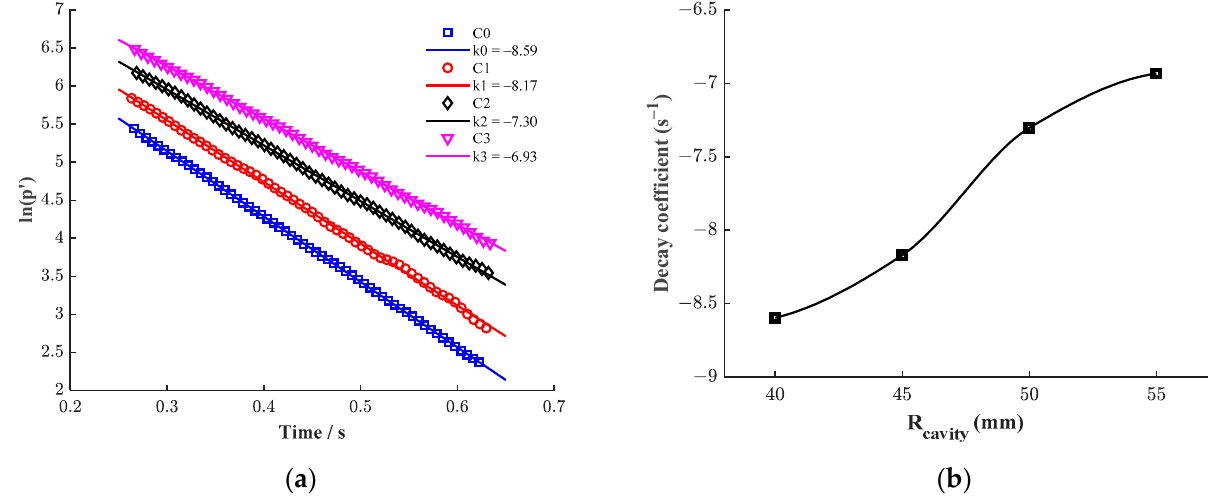
Figure 10. ln(cid:4666)𝑝′(cid:4667) (cid:3398) 𝑡 fitting lines and the decay coefficient under different cavity size. ( a ) ln(cid:4666)𝑝′(cid:4667) (cid:3398) Figure 10. ln ( p (cid:48) ) − t fitting lines and the decay coefficient under different cavity size. ( a ) ln ( p (cid:48) ) − t , 𝑡 , ( b ) The decay coefficient under different cavity size. ( b ) The decay coefficient under different cavity